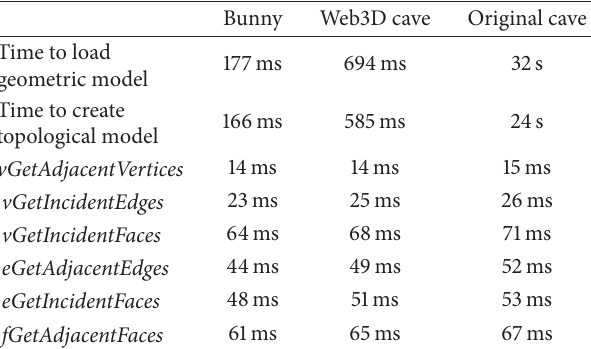
Table 7: Time to create topological model and to make 10 thousand adjacency and incidence random queries in the 3